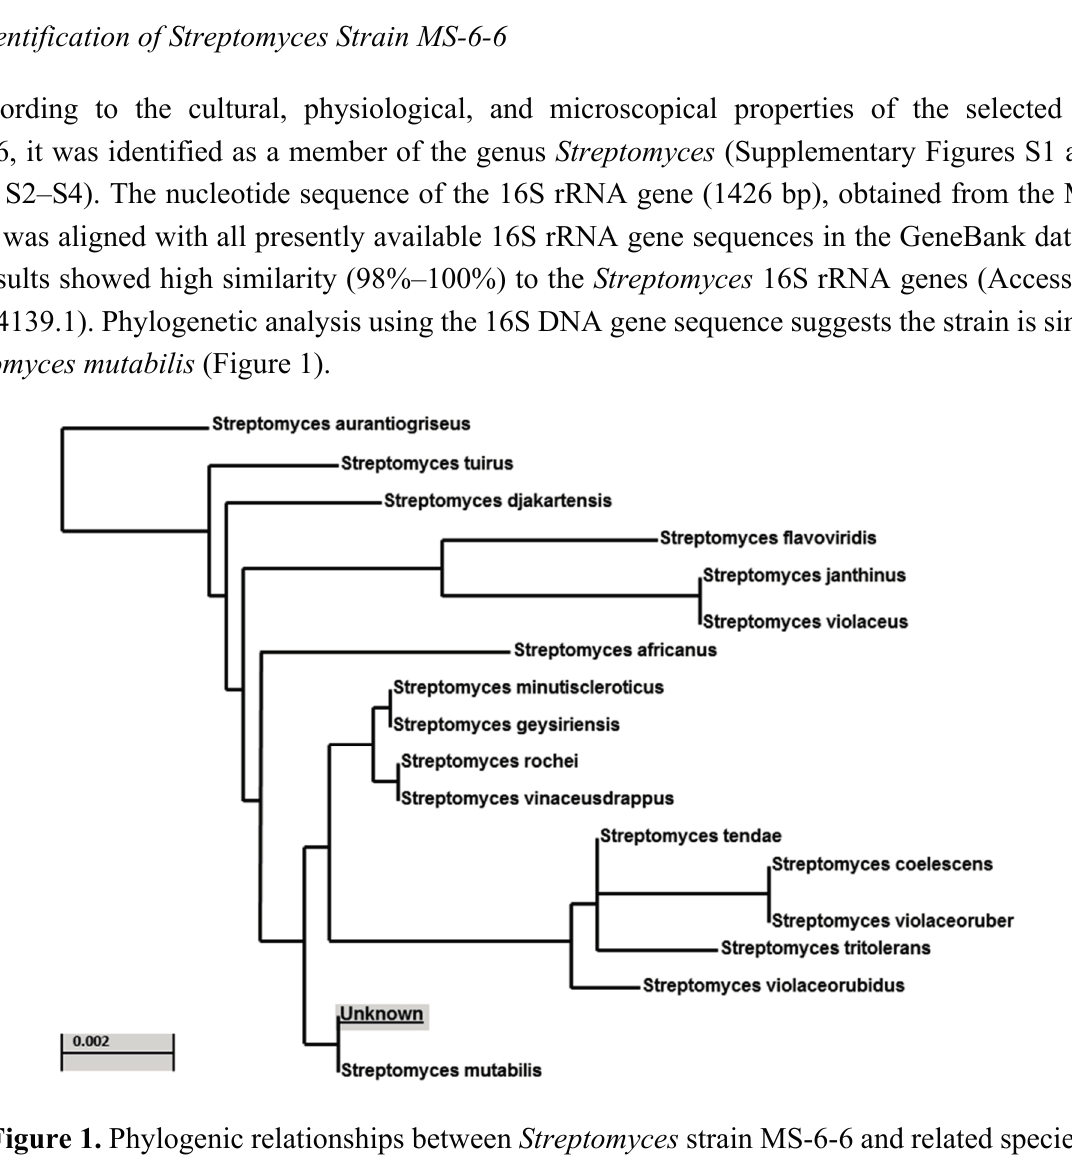
Figure 1. Phylogenic relationships between Streptomyces strain MS-6-6 and related species based on partial nucleotide sequence (1426 bp) of the 16S rRNA gene. The tree was constructed using the neighbor-joining method. The scale bar indicates a 0.002 substitution per nucleotide